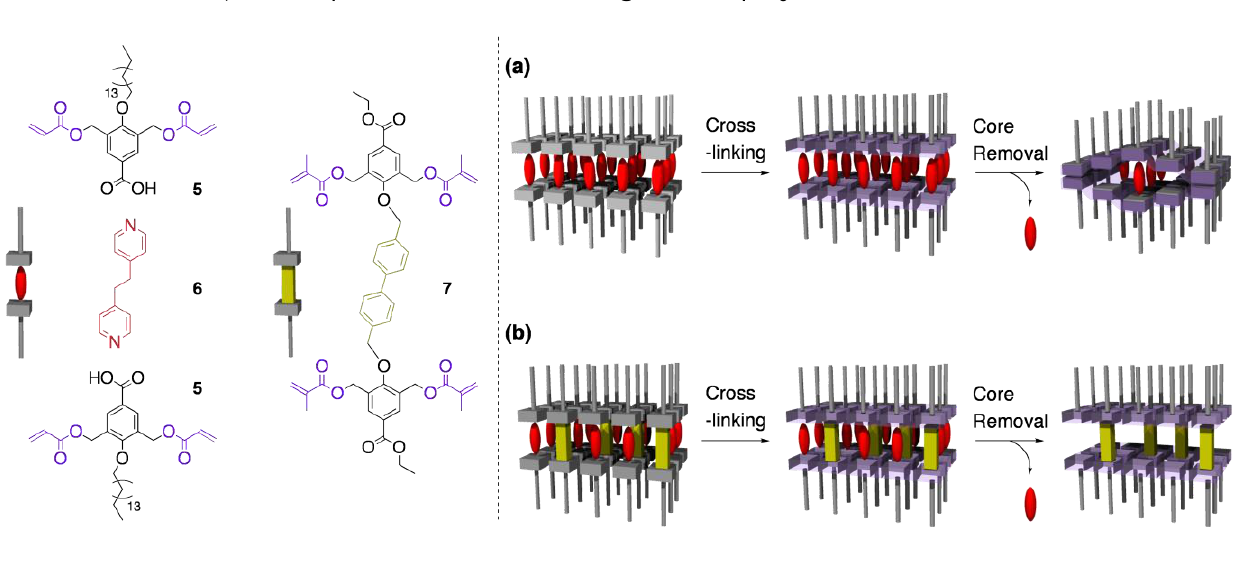
Figure 6. Schematic representation of the supramolecular monomer ( 5 - 6 - 5 ), the pillar molecule ( 7 ), and the processes of constructing ordered polymers from 5 - 6 - 5 and 7